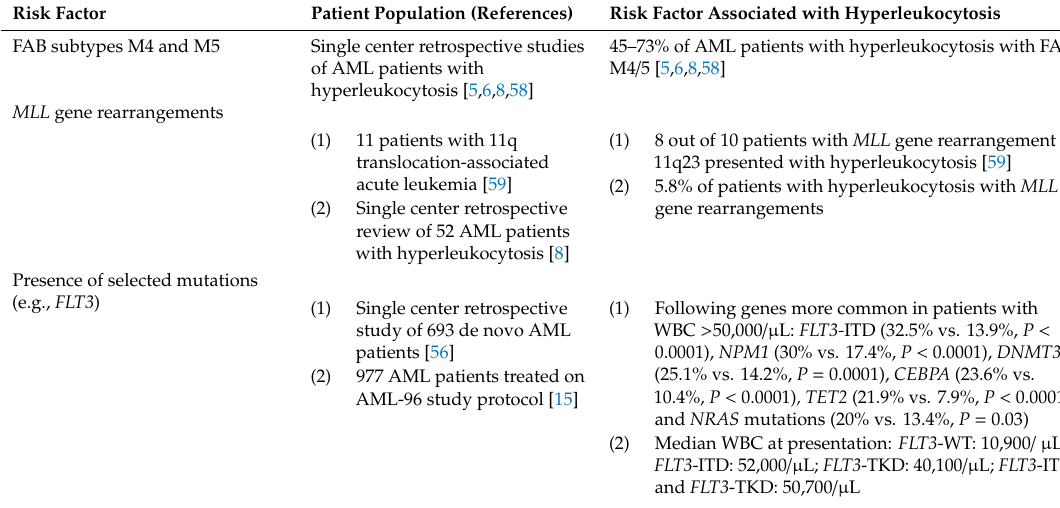
Table 1. Overview of selected studies identifying disease characteristics associated with hyperleukocytosis among AML patients.